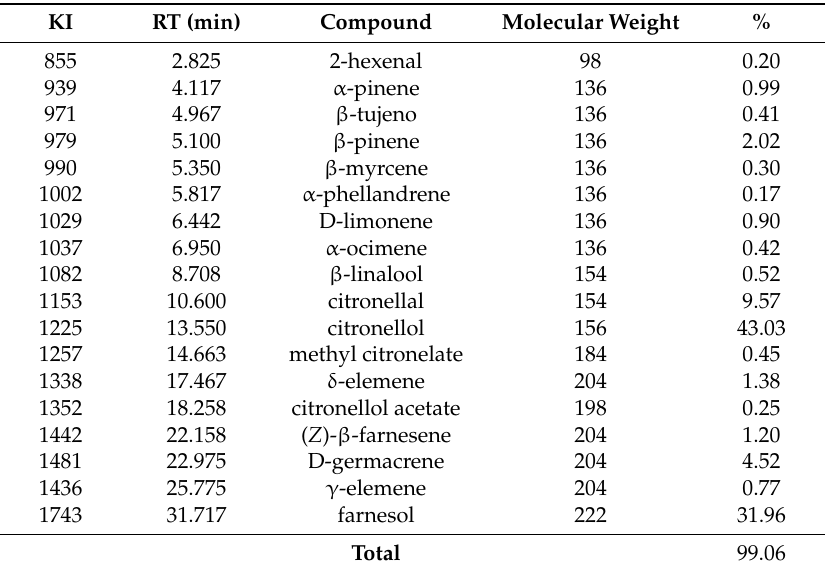
Table 2. Chemical composition of the essential oil of Z. monogynum .